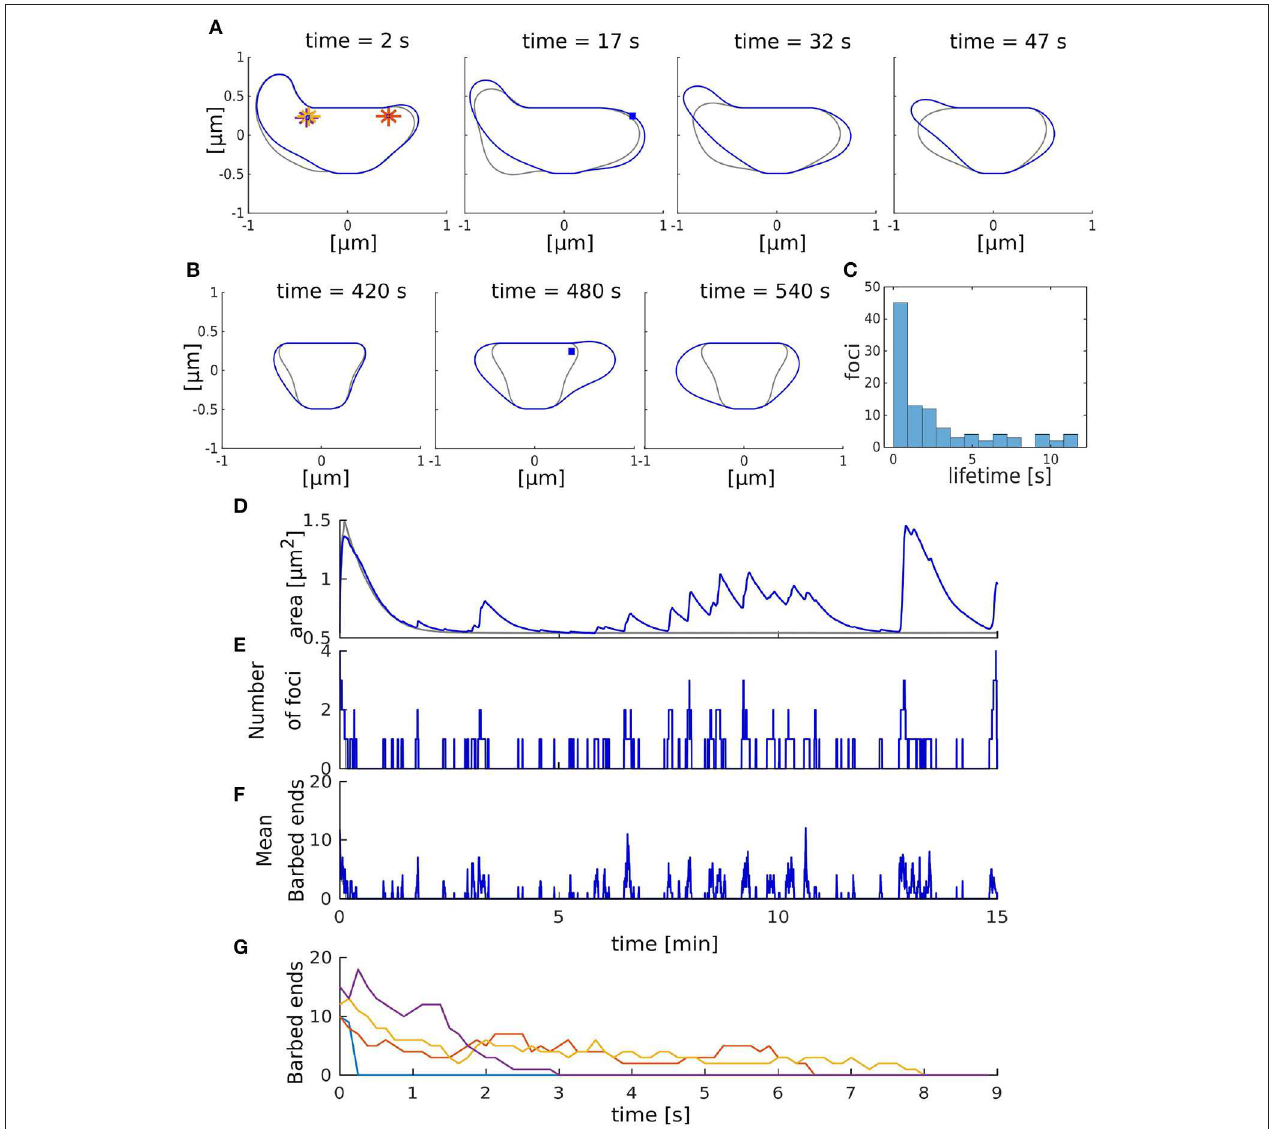
FIGURE 3 | Shape fluctuations of the spine. (A) Snapshots of the spine head shape with (blue line) and without (gray line) nucleation of new actin polymerization focus taken every 15 s. Asterisk correspond to the initial nucleation positions X n and blue squares indicate nucleation positions of the active foci at the indicated time. (B) Same as (A) but taken every 60 s. (C) Occurrence frequency of foci lifetime over all time-steps (of length 1 t ) in the simulation with nucleation. (D–F) Evolution of the spine area (D) , number of foci (E) , and mean number of barbed ends (F) over time. Gray and blue lines represent the simulation without and with nucleation of new foci, respectively. (G) Evolution of the number of barbed ends in each actin focus (color-coded) in the simulation without nucleation of new